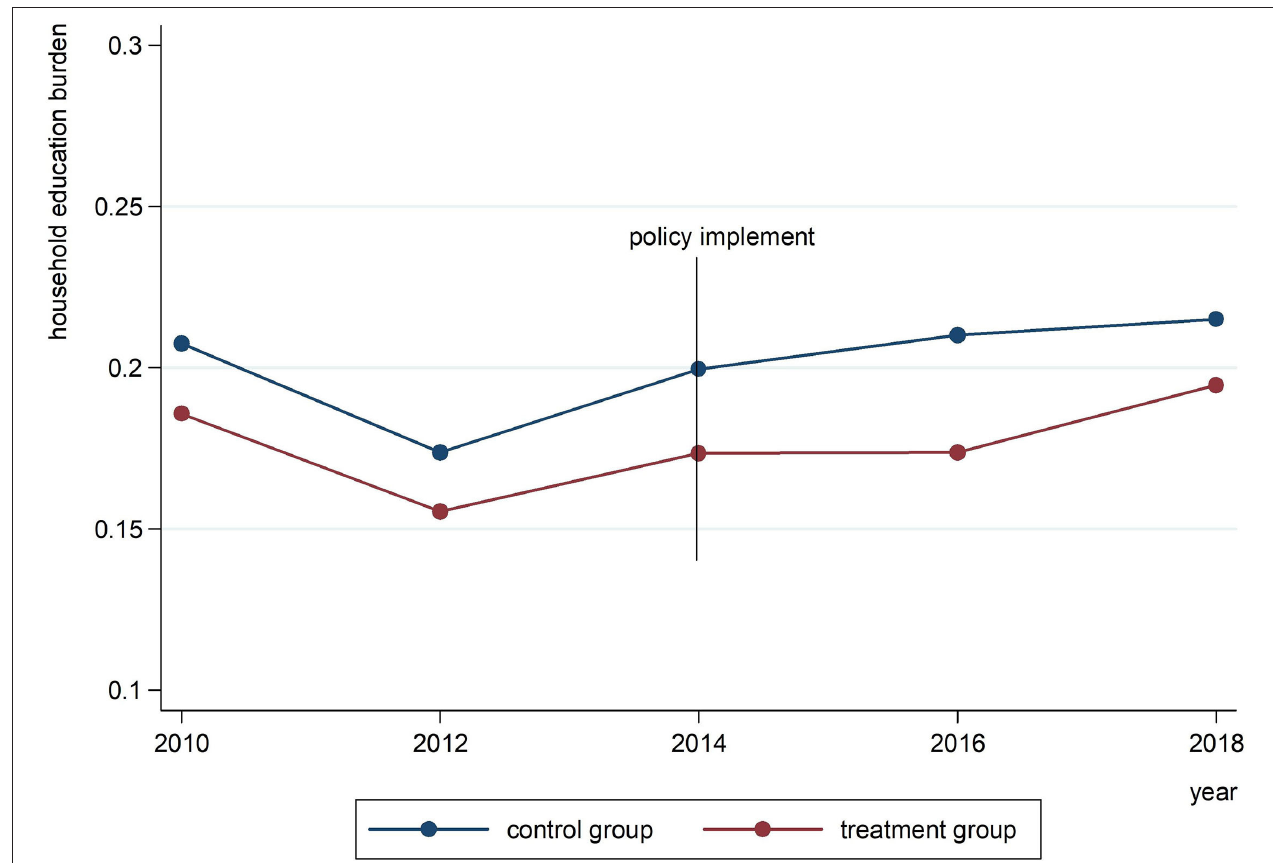
FIGURE 2 | The parallel trend